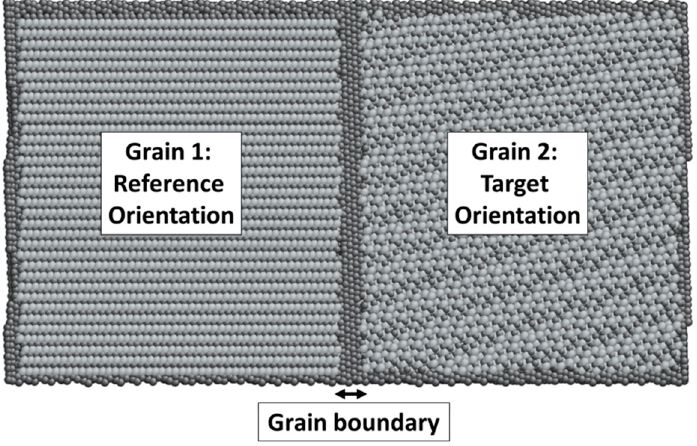
Figure 1. Simulation domain for elastic constants calculation. Grain 1 and grain 2 are arranged following specific disorientations. Grain boundaries are constructed between adjacent grains.